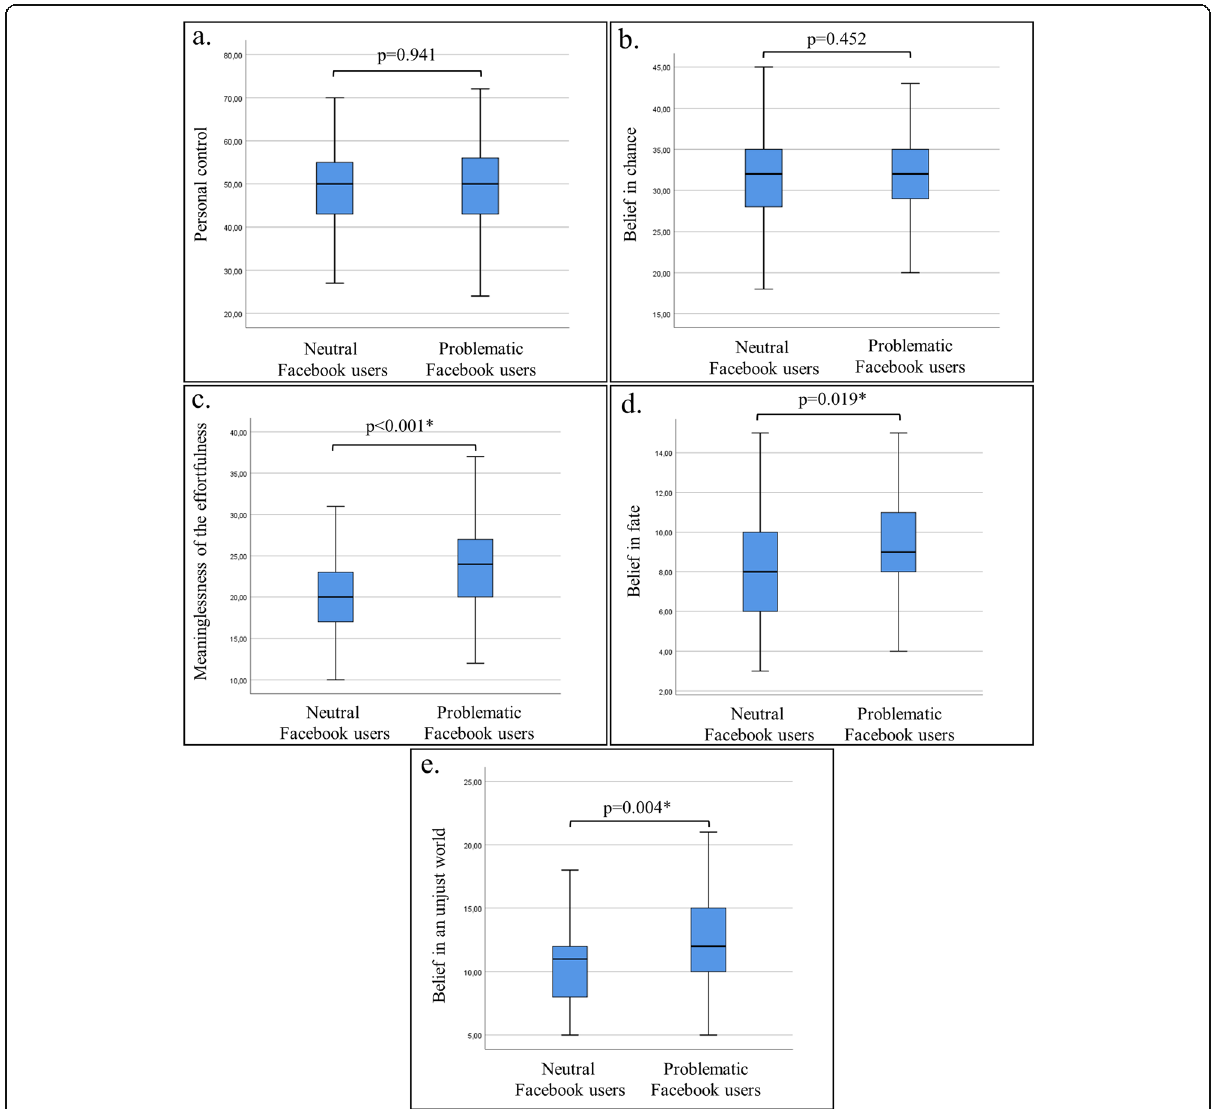
Fig. 1 Comparison of the locus of control domains ( a personal control, b belief in chance, c meaninglessness of the effortfulness, d belief in fate, e belief in an unjust world) between neutral vs. problematic Facebook users. Medians are shown by lines in the center of the box-plots; the 25th – 75th percentiles are indicated by the boxes and the range by the